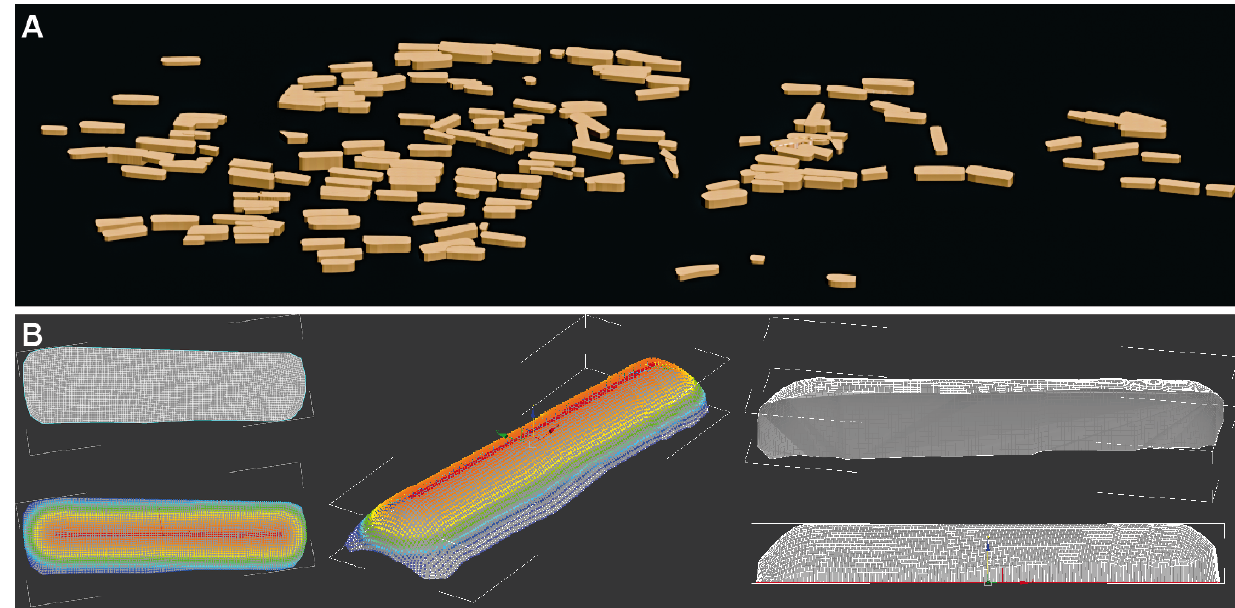
Figure 7. ( A ) Reconstruction of pit volumes; ( B ) steps in the process of reconstructing the mounds.